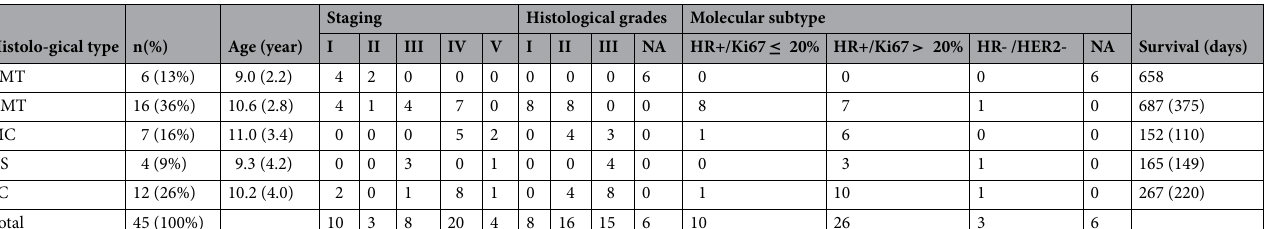
Table 1. Clinicopathological features of canine mammary neoplasms. For the age and the survival, the data are the mean values with the standard deviation in brackets. BMT benign mixed tumour, CMT carcinoma